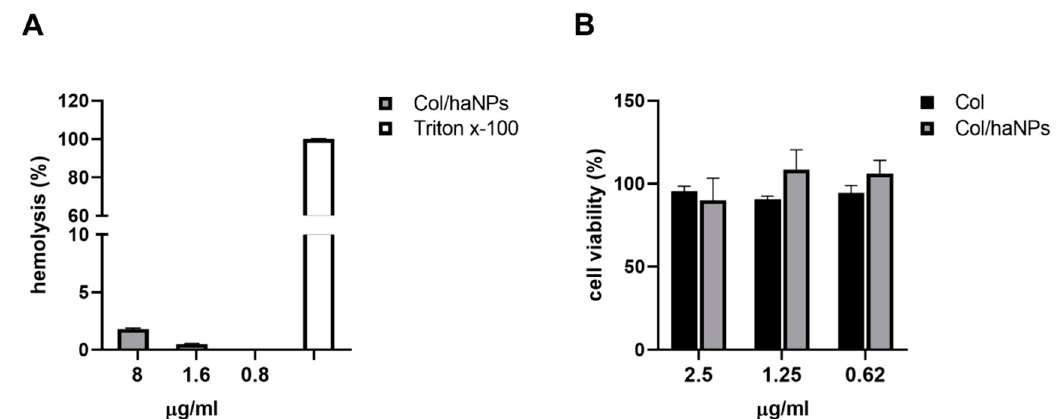
Figure 4. Col/haNPs biocompatibility. ( A ) Percentage of hemolysis induced by Col/haNPs at different concentrations. Triton x-100 was used as a positive control. ( B ) Graphical representation of the cytotoxic effect of Col/haNPs in comparison with Col free used at different concentrations (from the highest MIC of resistant strains) on HFF fibroblasts after treatment for 24 h. Untreated cells were used as control and set as 100%. Results are the mean values ± SEM of three independent experiments.